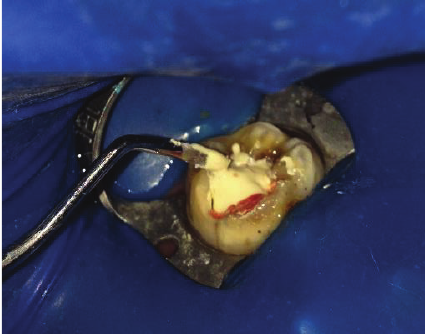
Figure28:PlacementofPRFandBiodentineovertheradicularpulp 36.